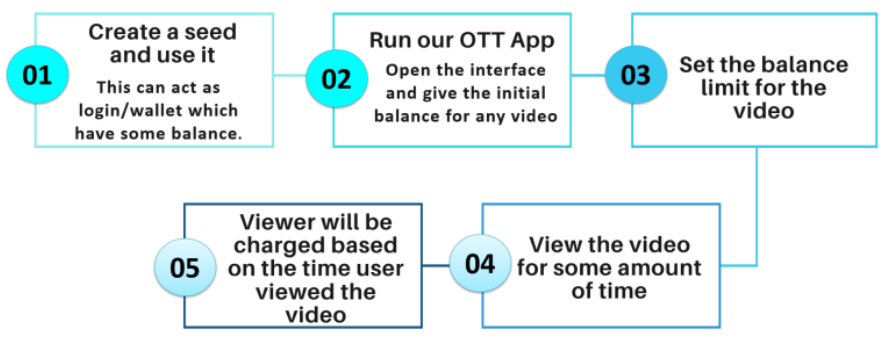
Figure 16. Transaction flow in PoC of MP-OTT.